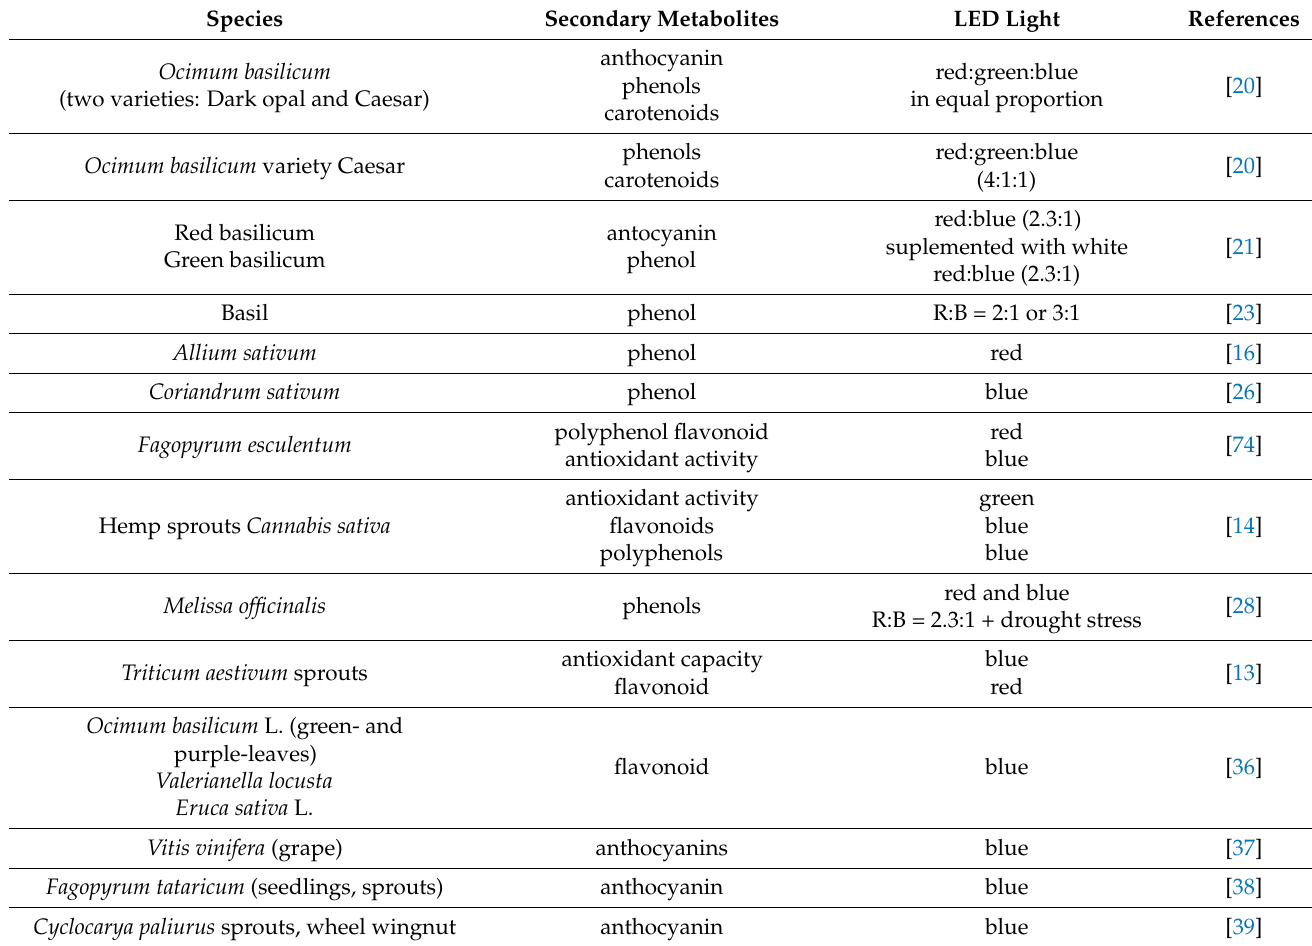
Table 2. The effect of LED on biosynthesis of secondary